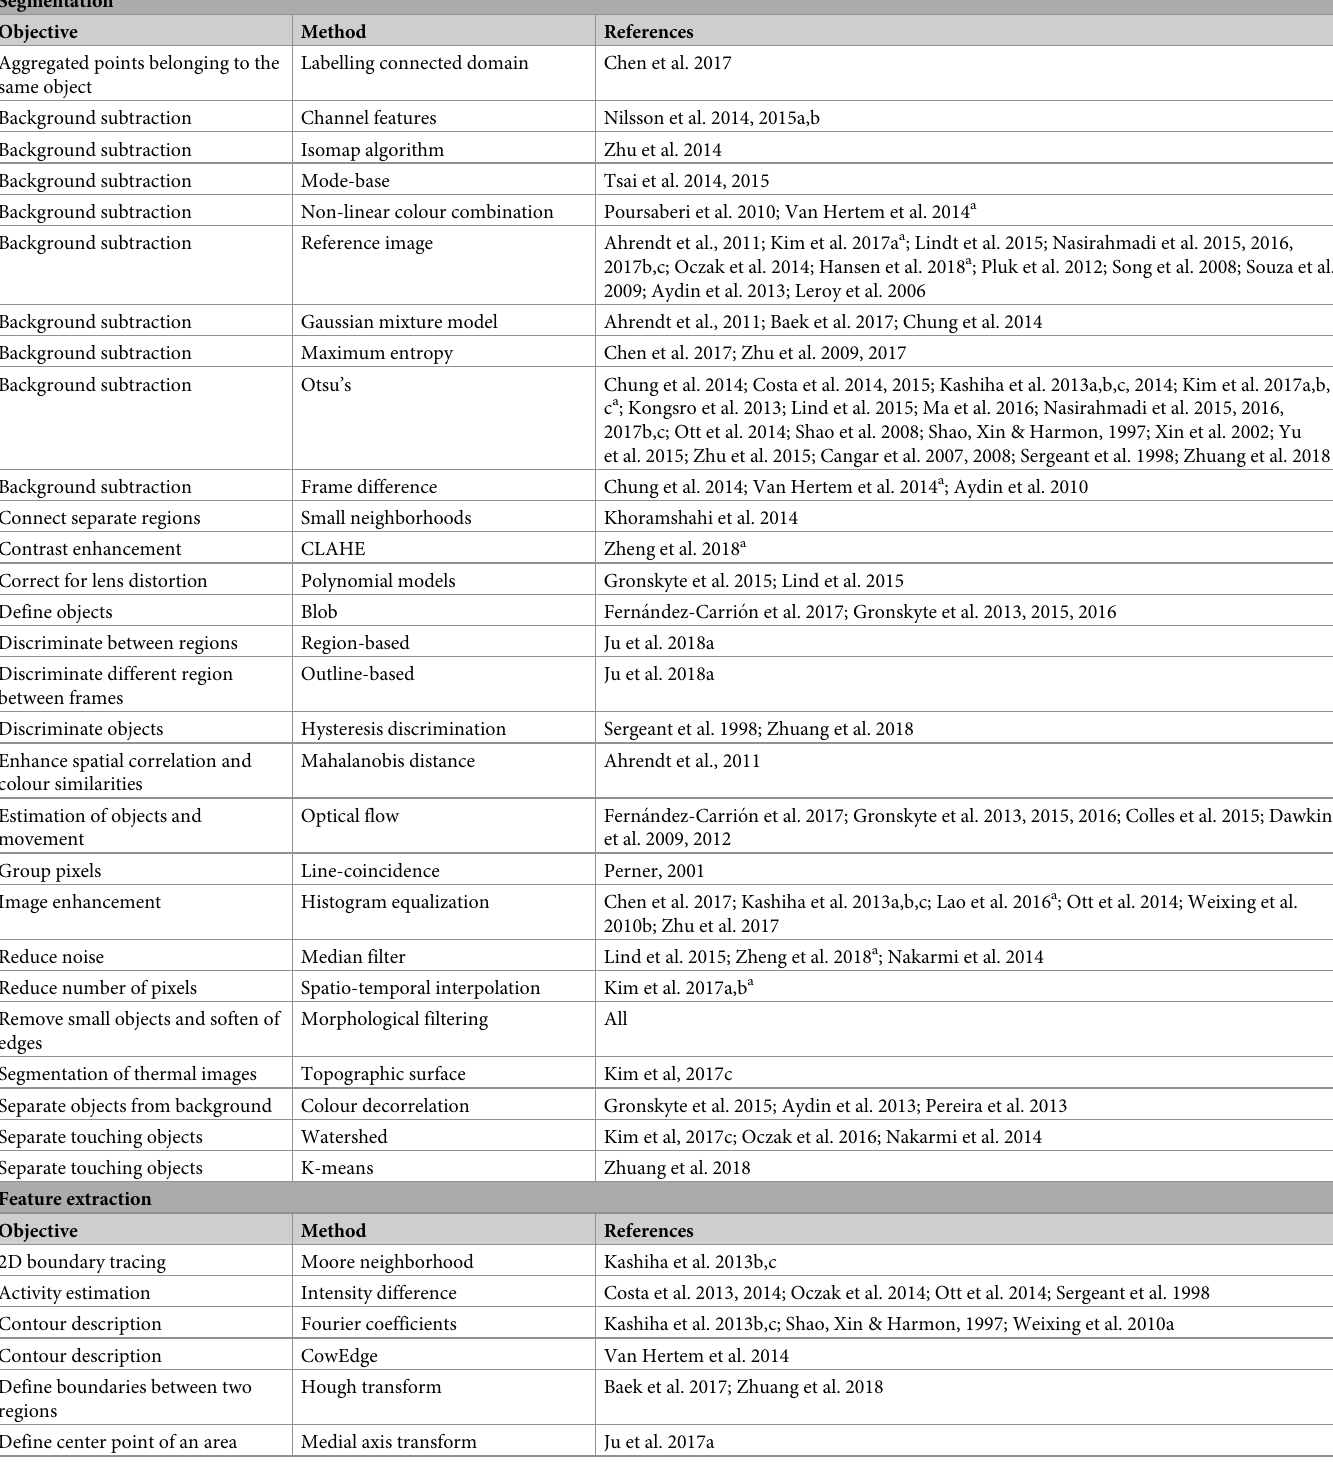
Table 1. Algorithms described in the reviewed literature and objectives for which they were